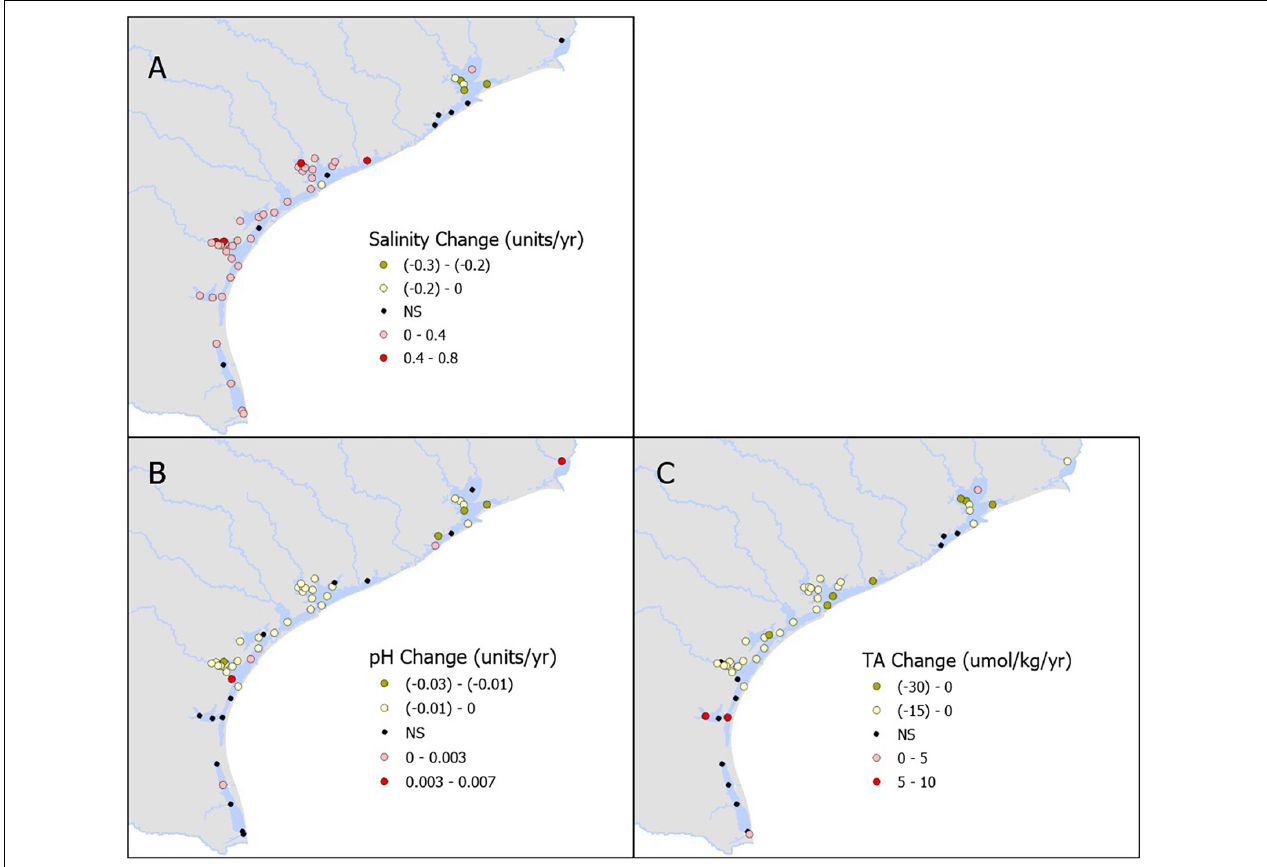
FIGURE 2 | Annual rate of change in the measured parameters- salinity (A) , pH (B) , and total alkalinity (C)